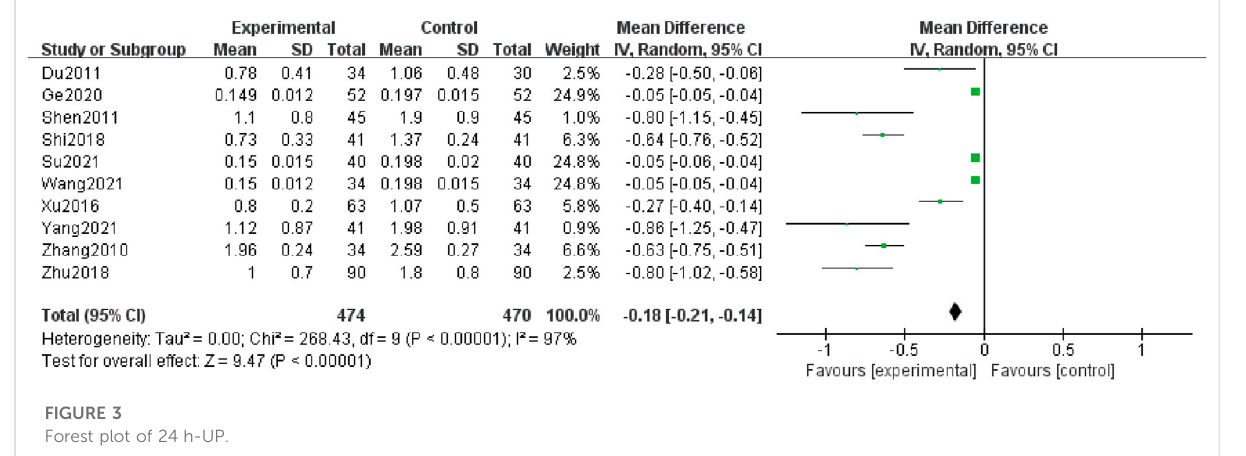
FIGURE 3 Forest plot of 24